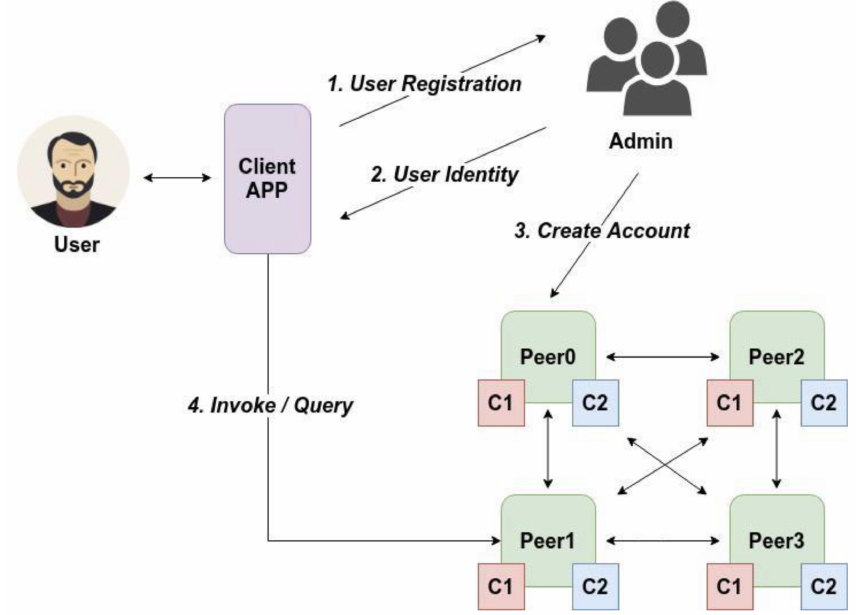
Figure 3. The interaction with the CA in the user registration process.